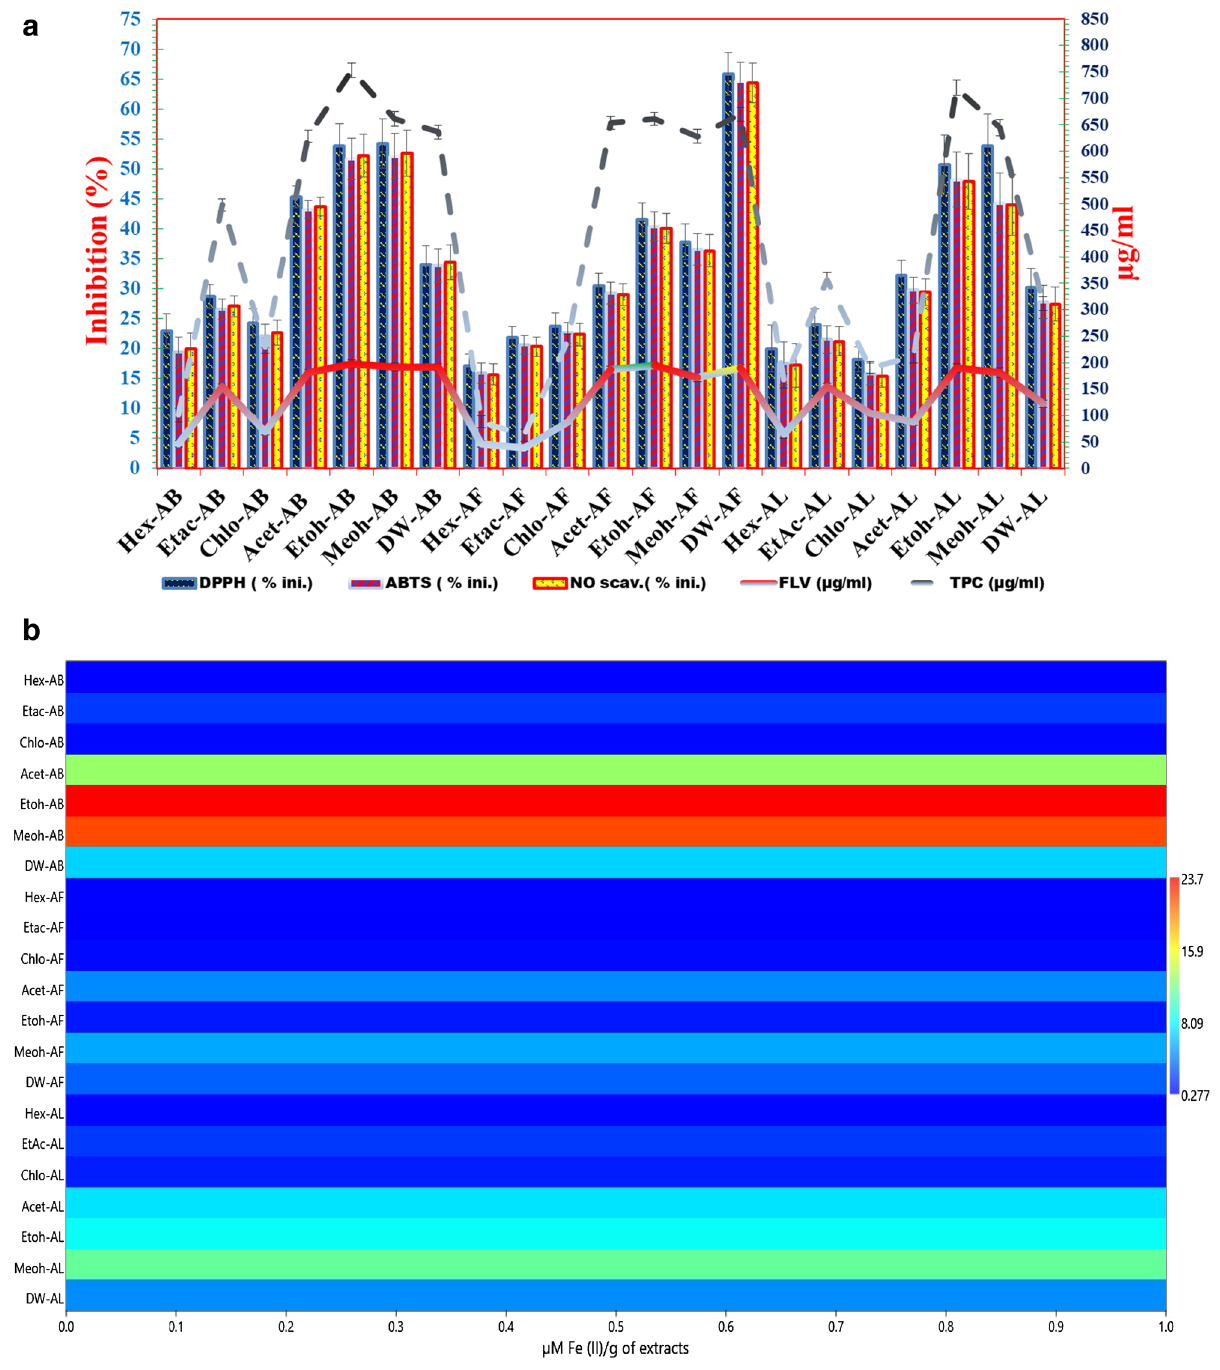
multiple bar of solvent extracts showed that Etoh-AB had the highest antioxidant and scavenging activity as compared to the solvent extracts. Dw-AF is the most effective among fruit extracts, and Etoh-AL is the most effective among leaf extracts ( a ). The comparative FRAP capacity of the extracts ranged from 0.277 to 23.7 µM Fe(II)/g of extracts ( b ). ( b ) Comparative effects of solvent extracts based on FRAP